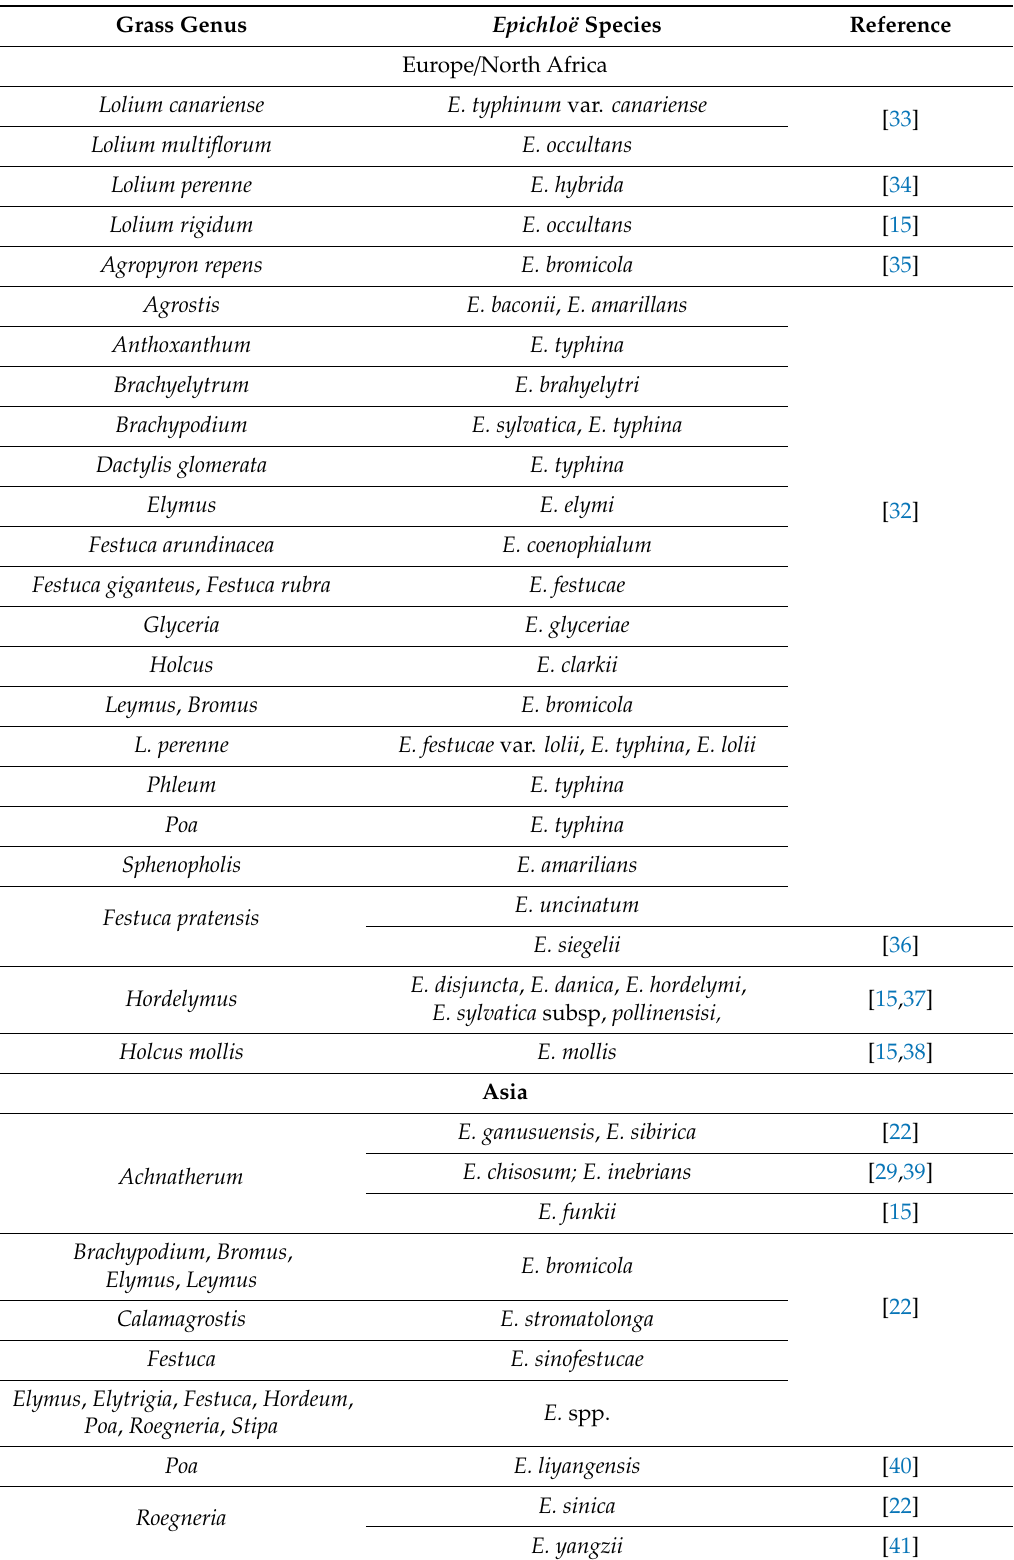
Table 1. Infection of Epichloë species in temperate grasses by region – for more extensive and detailed listings